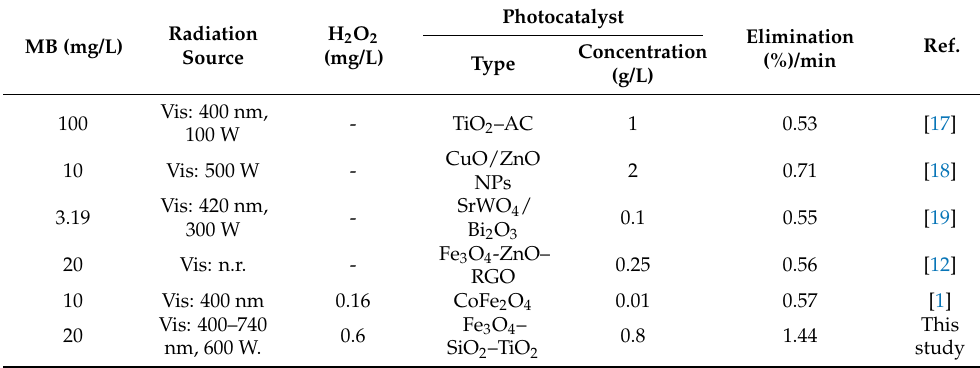
Table 1. Results for MB degradation attained during last year’s photocatalysis processes (n.r.: not